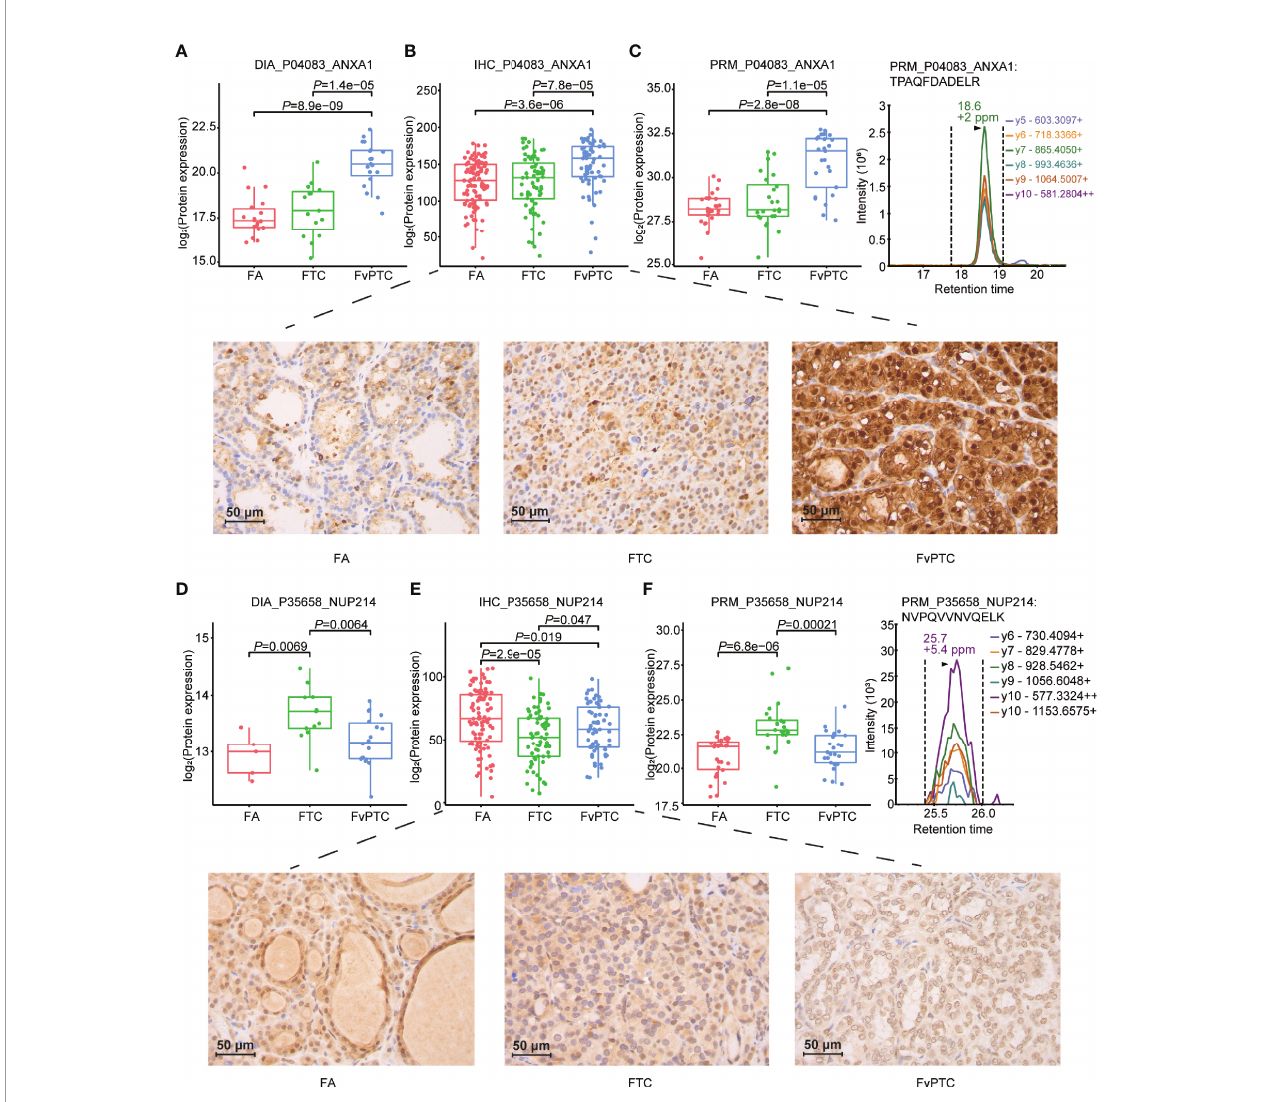
FIGURE 5 | Validation study. Representative results of PCT-DIA, PRM-MS, and immunohistochemical staining of ANXA1 (A – C) , NUP214 (D – F) in FA, FTC and FvPTC